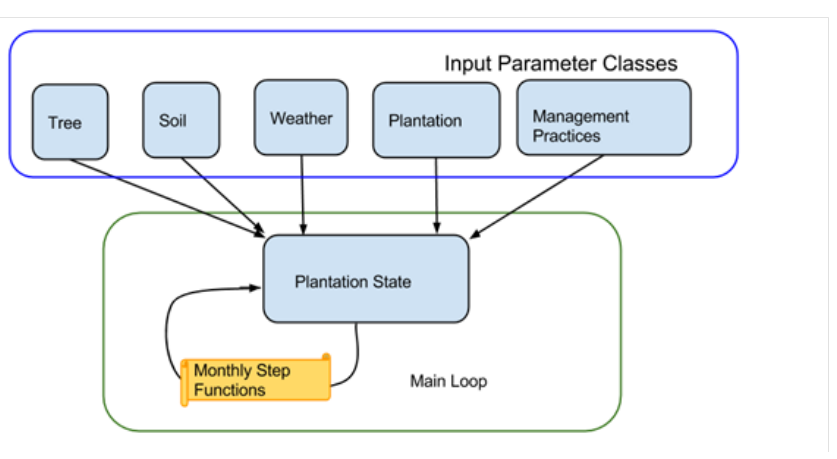
Figure 1. Model interaction